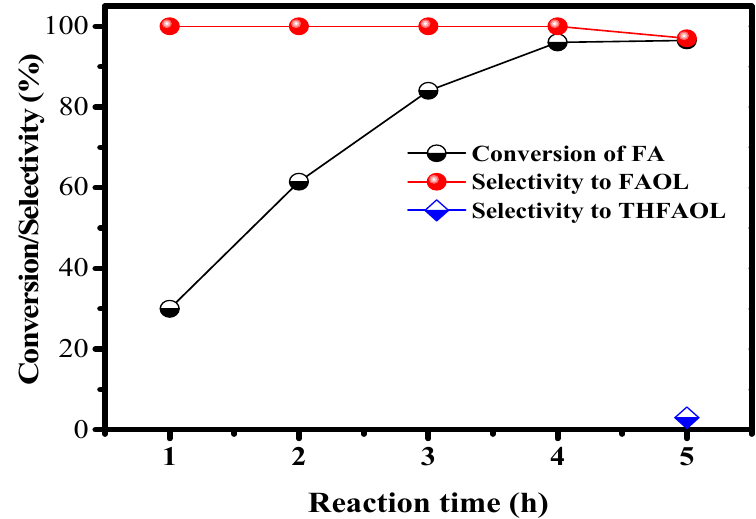
Figure 12. The e ff ect of reaction time on the CTH of FA over 5CuHAp. Reaction Conditions: The catalyst Figure 12. The effect of reaction time on the CTH of FA over 5CuHAp. Reaction Conditions: The amount (100 mg), 2-propanol (5 mL), FF (480 mg), reaction temperature—140 ◦ C at 2 MPa N 2 pressure catalyst amount (100 mg), 2-propanol (5 mL), FF (480 mg), reaction temperature—140 °C at 2 MPa N 2 and reaction time—(1–5 pressure and reaction time—(1–5 h).